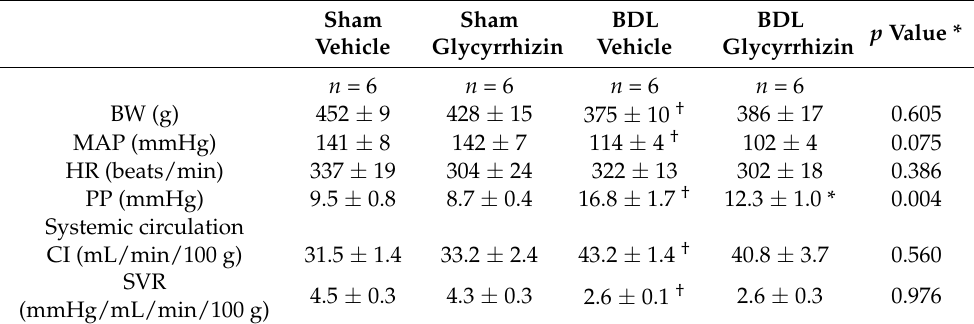
Table 1. Hemodynamic parameters in sham or BDL rats treated with vehicle or glycyrrhizin.